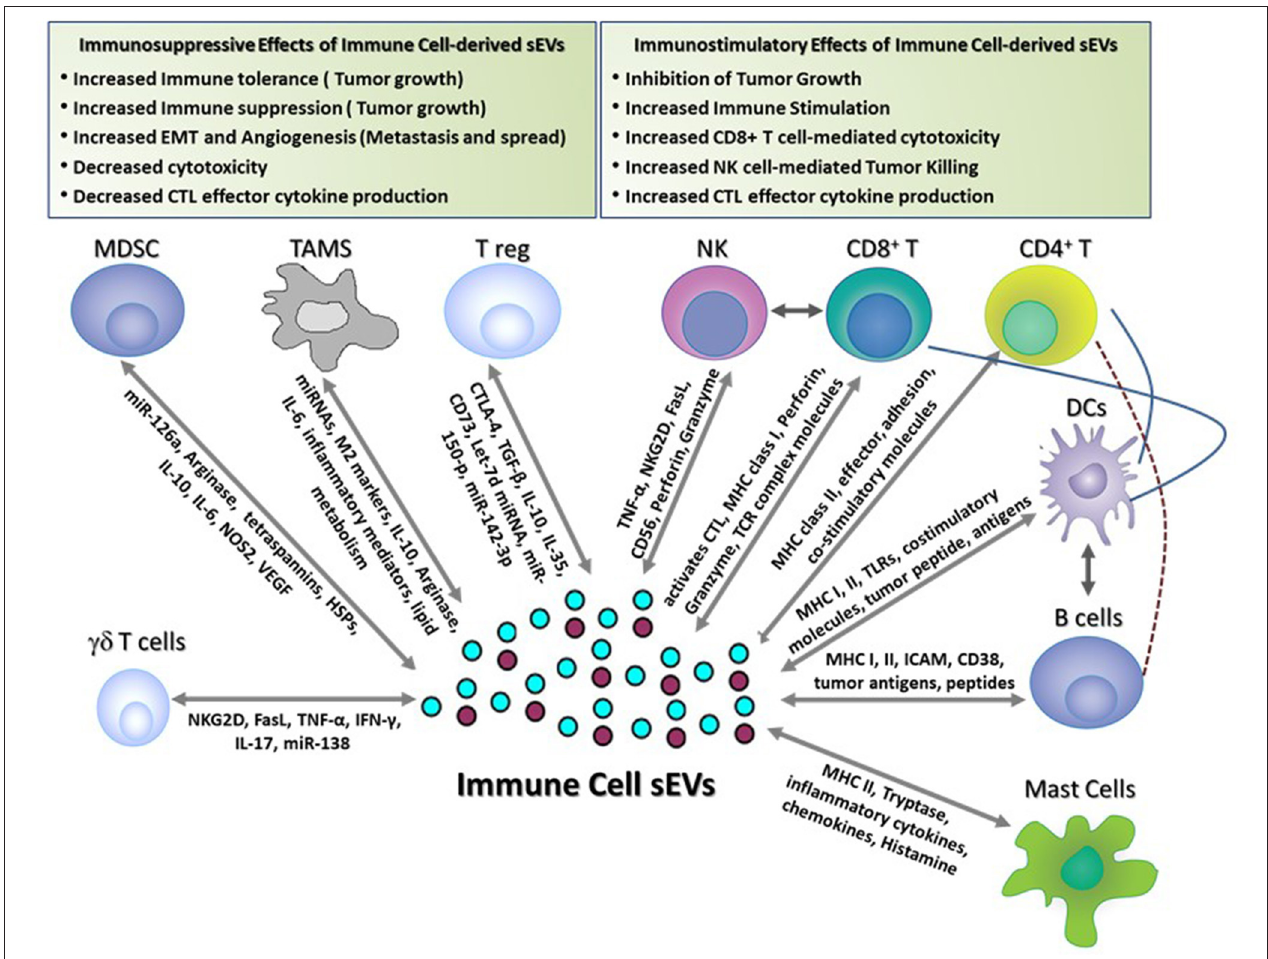
FIGURE 1 | Immune-stimulatory and suppressive effects of immune cell-derived sEVs in cancer. This figure shows the different functions of immune cell-derived sEVs that have been reported to play a role in modulating immune responses in tumor-bearing hosts. These sEVs activate anti-tumor immune responses and inhibit tumor growth by (1) inducing Dendritic cell- and B cell-mediated antigen presentation, (2) promoting CD4 + T cell helper responses, (3) activating CD8 + T cell- and NK cell-mediated effector responses and cytotoxicity, and (4) inducing mast cell-mediated secretion of immune regulatory cytokines and chemokines. Conversely, immune cell-derived sEVs suppress the immune responses and promote tumor growth, invasion, and metastasis by (1) suppressing T cell-mediated anti-tumor effector responses and cytotoxicity, (2) promoting angiogenesis and EMT, (3) inducing FasL-mediated T cell apoptosis, and (4) producing immune suppressive soluble mediators and